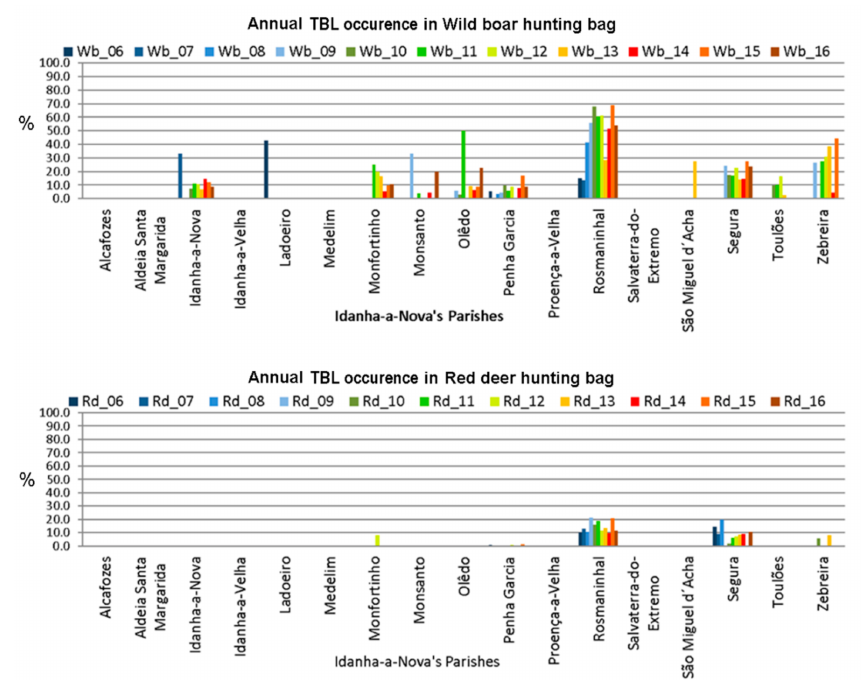
Figure 6. TBL occurrence variation across Idanha-a-Nova’s parishes from 2006 to 2016. ( top ): wild boar; ( bottom ): red